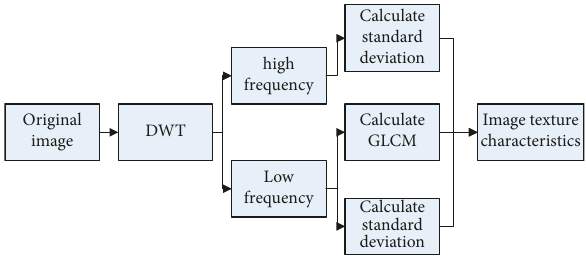
Figure 1: Feature extraction process based on